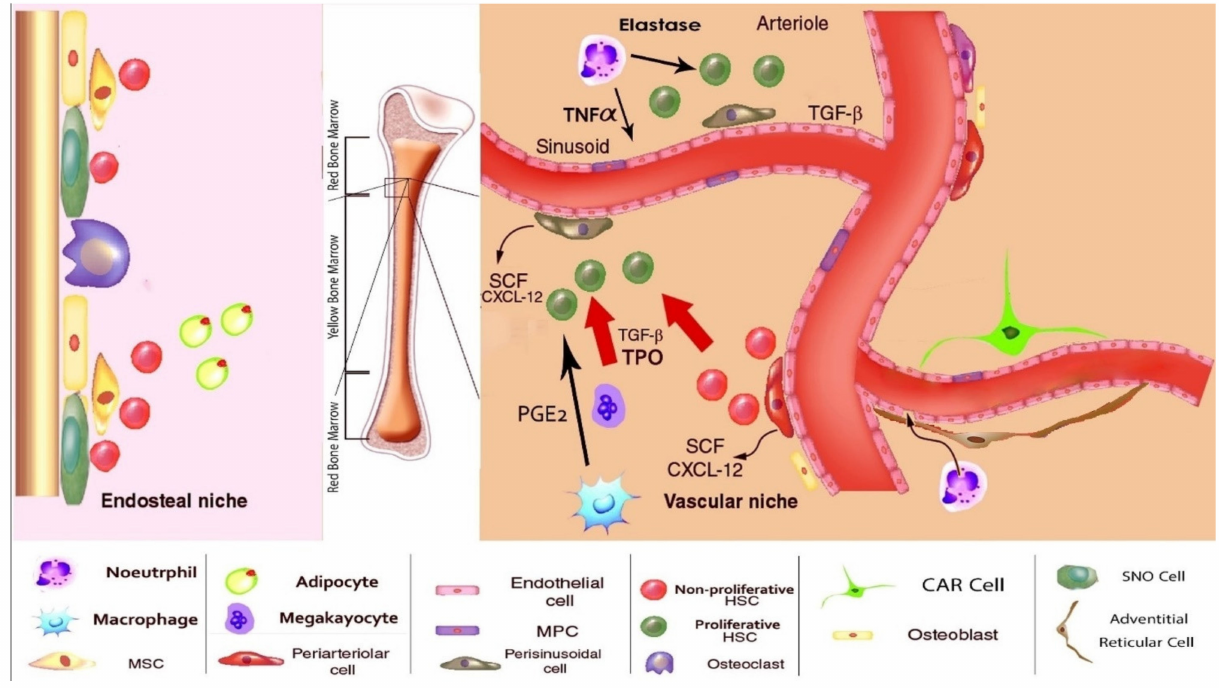
Figure 1. The endosteal and vascular bone marrow niche. The endosteal niche hosts quiescent or self-renewing HSCs. The vascular niche hosts differentiating HSCs using cell-cell interactions and secreted molecules. This figure is adopted from [98]. CAR cells, CXCL12-abundant reticular cells; HSC, Hematopoietic stem cells; MSC, mesenchymal stem cells; MPC, Myeloid progenitor cells; PGE 2 , Prostaglandin E 2 ; SCF, Stem Cell Factor; SNO cell, spindle-shaped N-cadherin+CD45- osteoblastic cell; TNF- α , Tumors Necrosis Factor α ; TPO,